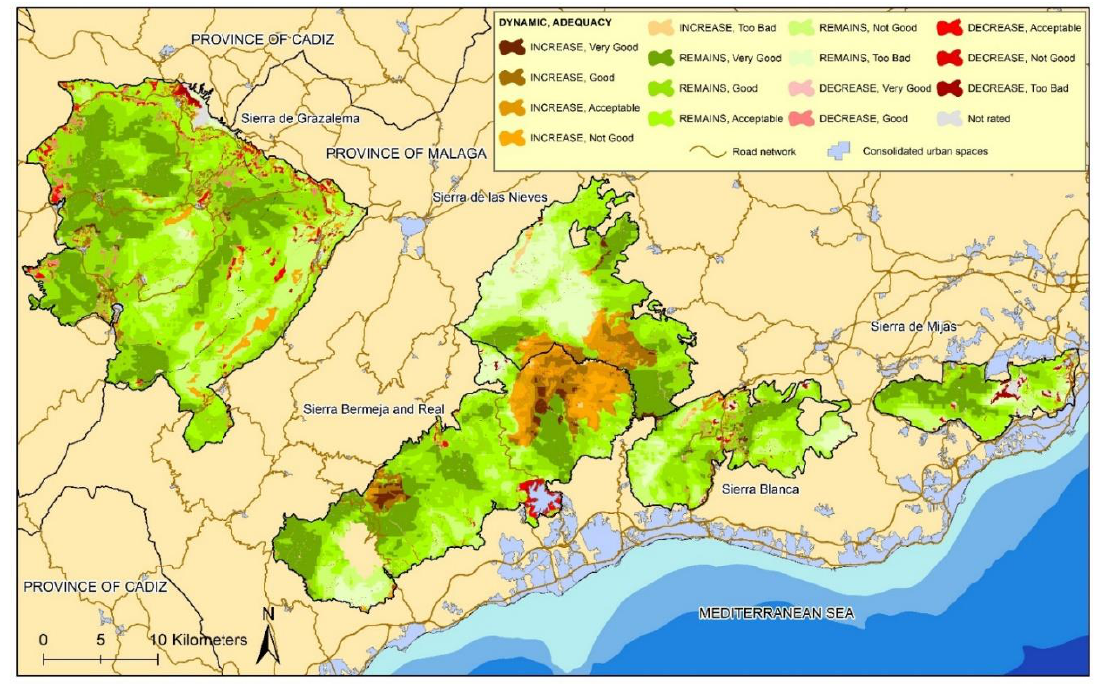
Figure 8. Dynamics of changes in vegetation cover (1991 – 2021). Natural areas to the west of the study area. Province of Cadiz and Malaga. Own elaboration based on data of Cartography of the Uses and Vegetation Covers of the soil of Andalusia (1991) and the Geographical Information System for the Identification of Agricultural Land Parcels (SIGPAC) (2021).